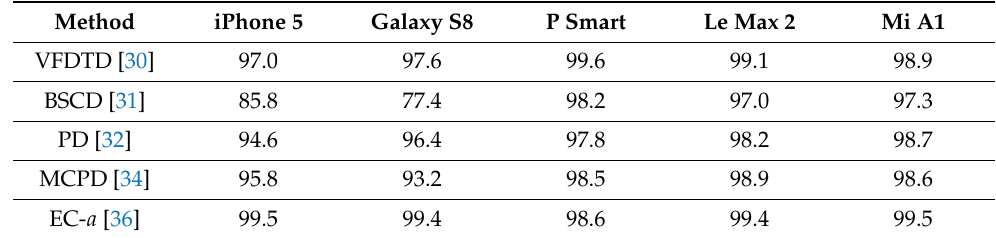
Table 3. Transient starting point detection rates (%) at medium SNR.